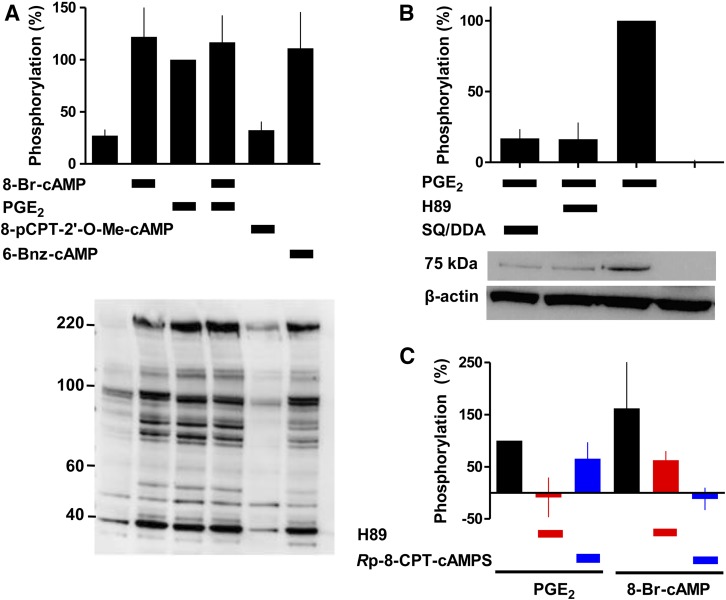
PGE2 and 8-Br-cAMP stimulate PKA-mediated protein phosphorylation. (A) Typical immunoblot using AbP2 (see Materials and
Methods) showing PKA-phosphorylated proteins from cells stimulated with cAMP analogs (10 mM, 20 minutes) or PGE2 (10 μM, 5 minutes). Summary results (means ± S.D., n = 3–4) show the band intensity across the entire gel as a percentage of that from cells stimulated with PGE2. Mr markers (kilodaltons) shown alongside gel. (B) Similar analyses using AbP1 show the effects of H89 (10 μM, 10 minutes) or SQ/DDA (1 mM SQ22536 and 200 μM DDA, 20 minutes) on the phosphorylation of a 75-kDa band in response to PGE2 (10 μM. 5 minutes). Summary results (means ± S.D., n = 3–5) show band intensities as percentages of the matched response to PGE2 alone. (C) Similar analysis to (A), for cells stimulated with PGE2 (10 μM, 5 minutes) or 8-Br-cAMP (10 mM, 20 minutes) alone or after incubation (20 minutes) with Rp-8-CPT-cAMPS (1 mM) H89 (10 μM). Results (means ± S.D., n = 3–4) show the increase in phosphorylation evoked by the indicated stimuli expressed as a percentage of the matched response to PGE2 alone.